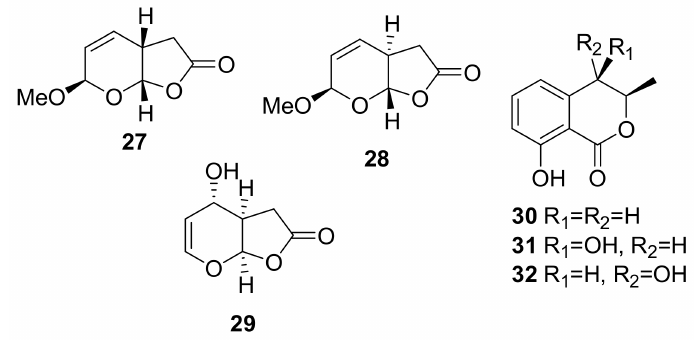
Figure 2. The structures of afritoxinones A and B ( 27 and 28 ), oxysporone ( 29 ), R -( − )-mellein, (3 R ,4 R )-4-hydroxymellein, and (3 R ,4 S )-4-hydroxymellein ( 30 – 32 ).